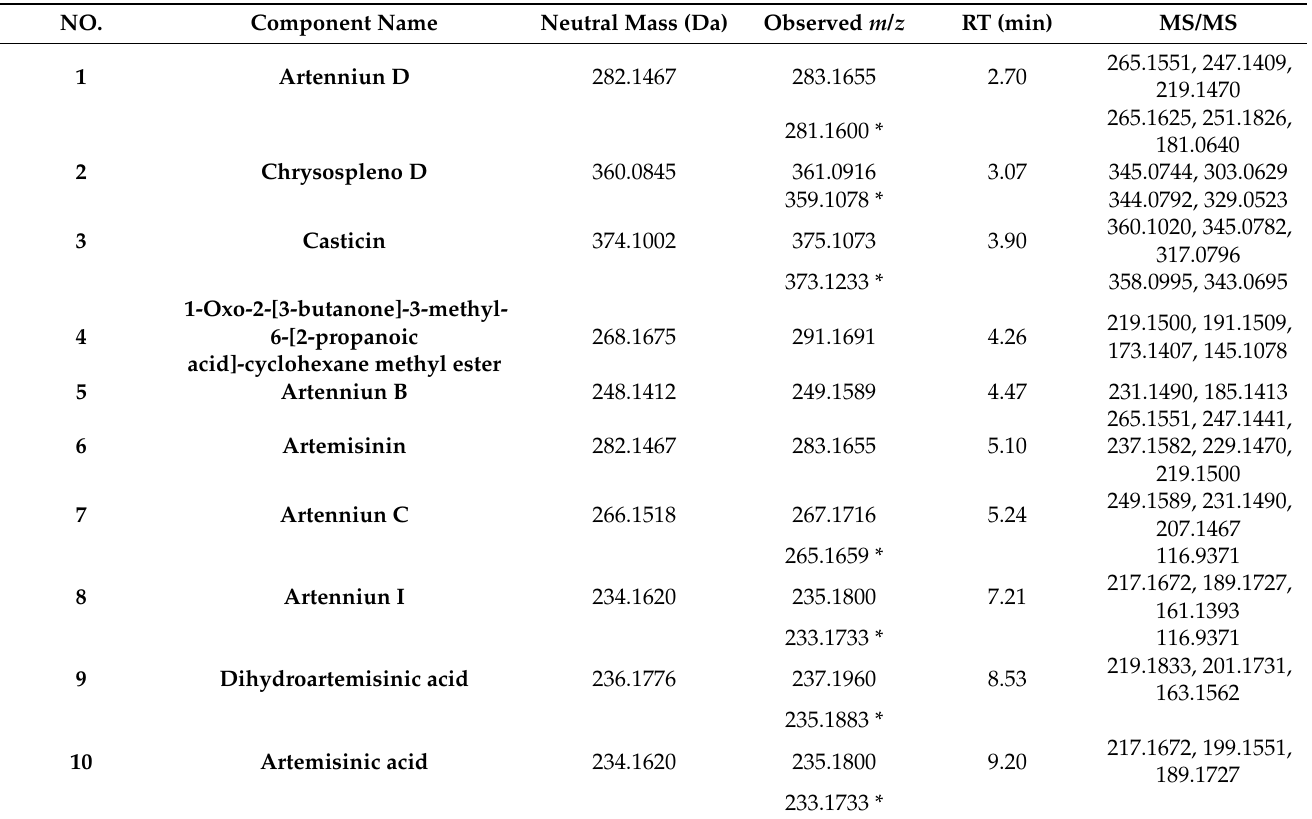
Table 2. LC-MS data of Artemisia annua L. based on UPLC-Q-TOF-MS/MS for identification of reference samples.